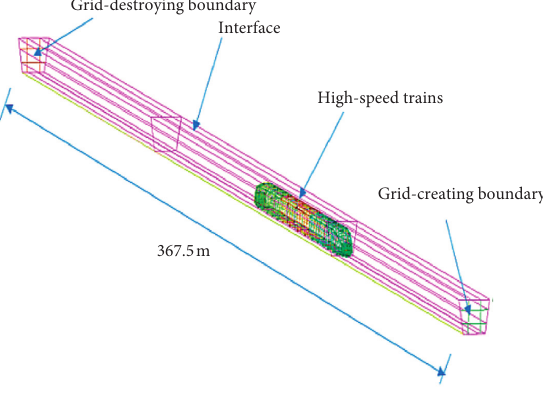
Figure 5: Dynamic layering